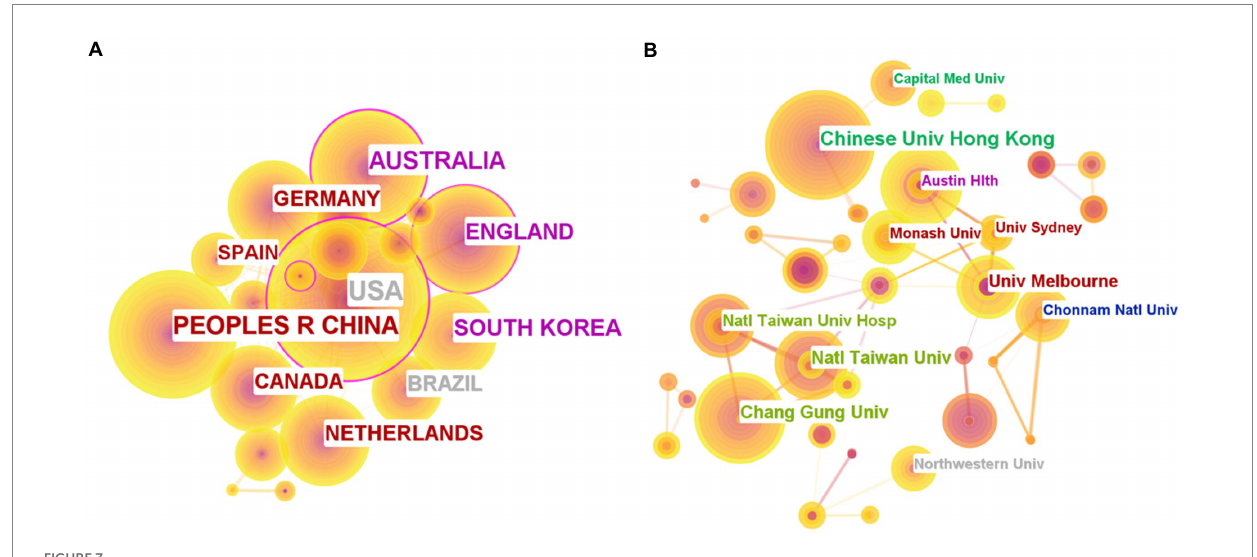
FIGURE 7 (A) Map of countries. (B) Map of